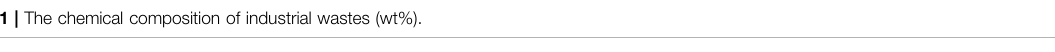
TABLE 1 | The chemical composition of industrial wastes (wt%). Composition SiO 2 Red